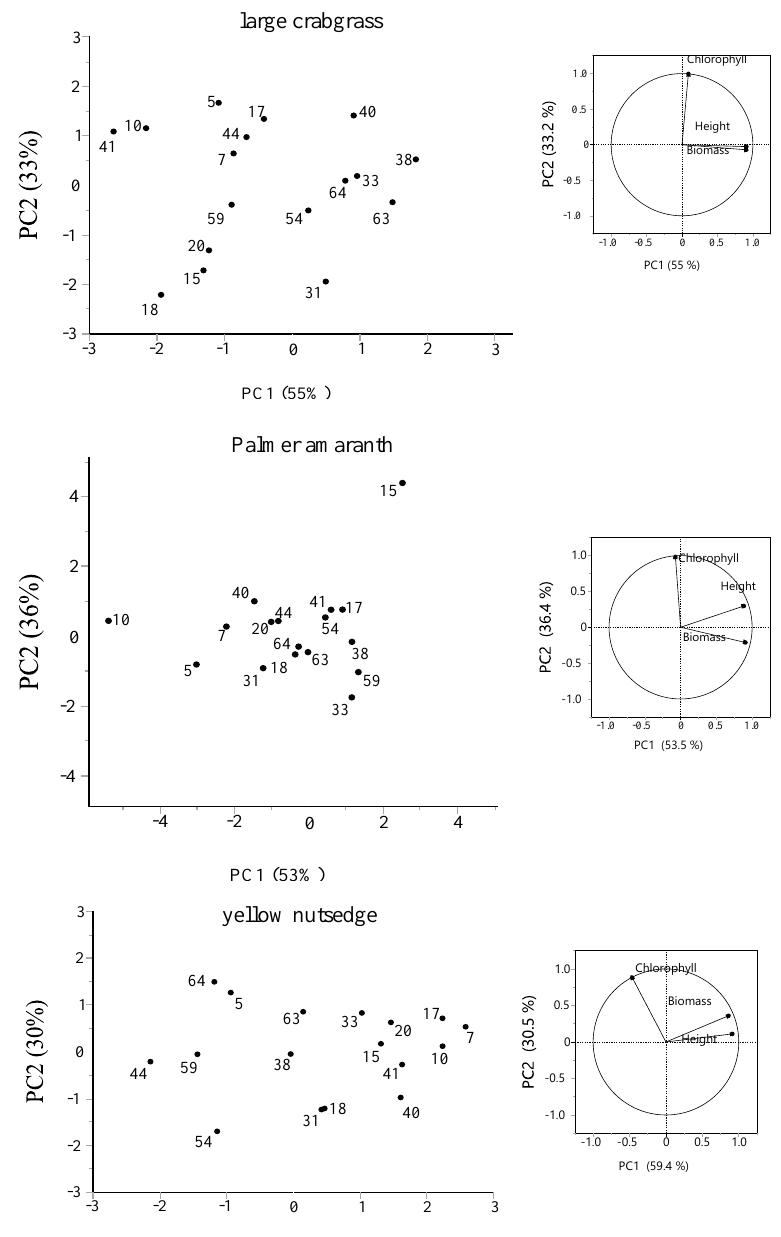
Figure 5. Principal component analysis (PCA) is based on three components: height, chlorophyll, and biomass. The proportion of variances for principal components (PC) 1 and 2 are shown in